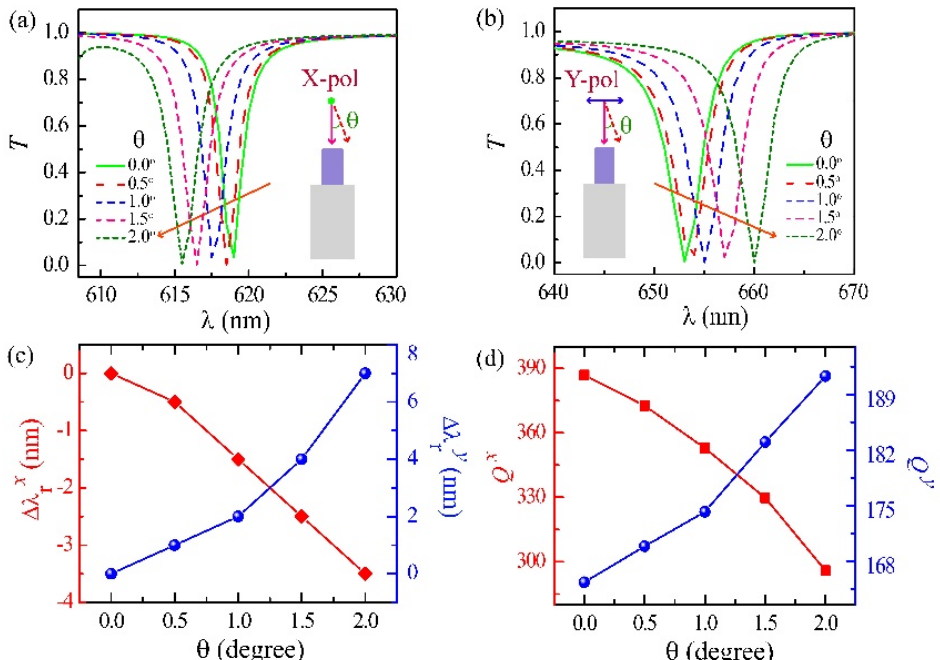
Figure 7. Effect of incident angle of source ( θ ) in the optical responses. ( a , b ) Show the variation in T with the λ for different θ in X-pol and Y-pol lights, respectively. ( c , d ) Show the resonance peak shift ( ∆ λ ) and variation of Q -factor with θ for both polarized lights, respectively.